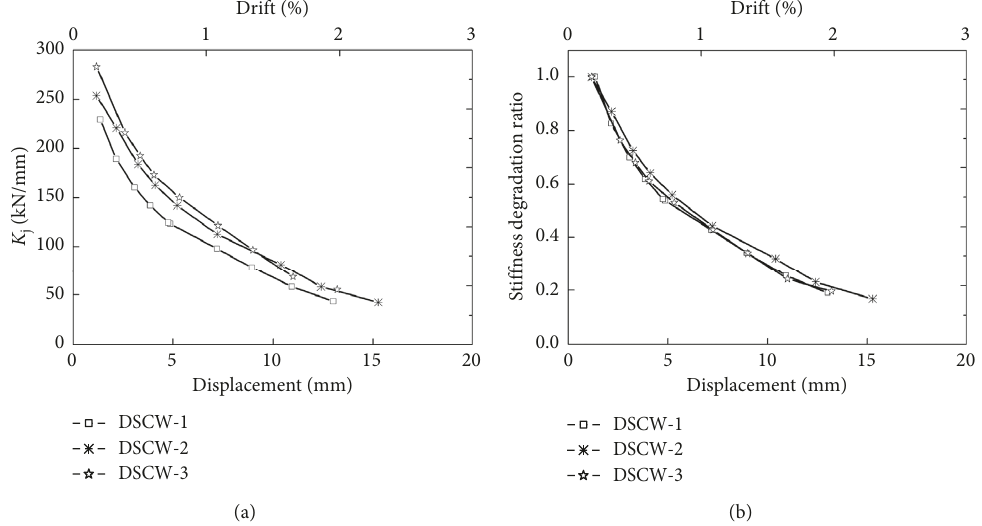
Figure 10: Stiffness degradation of specimens. (a) Stiffness degradation curves. (b) Stiffness degradation ratio curves.